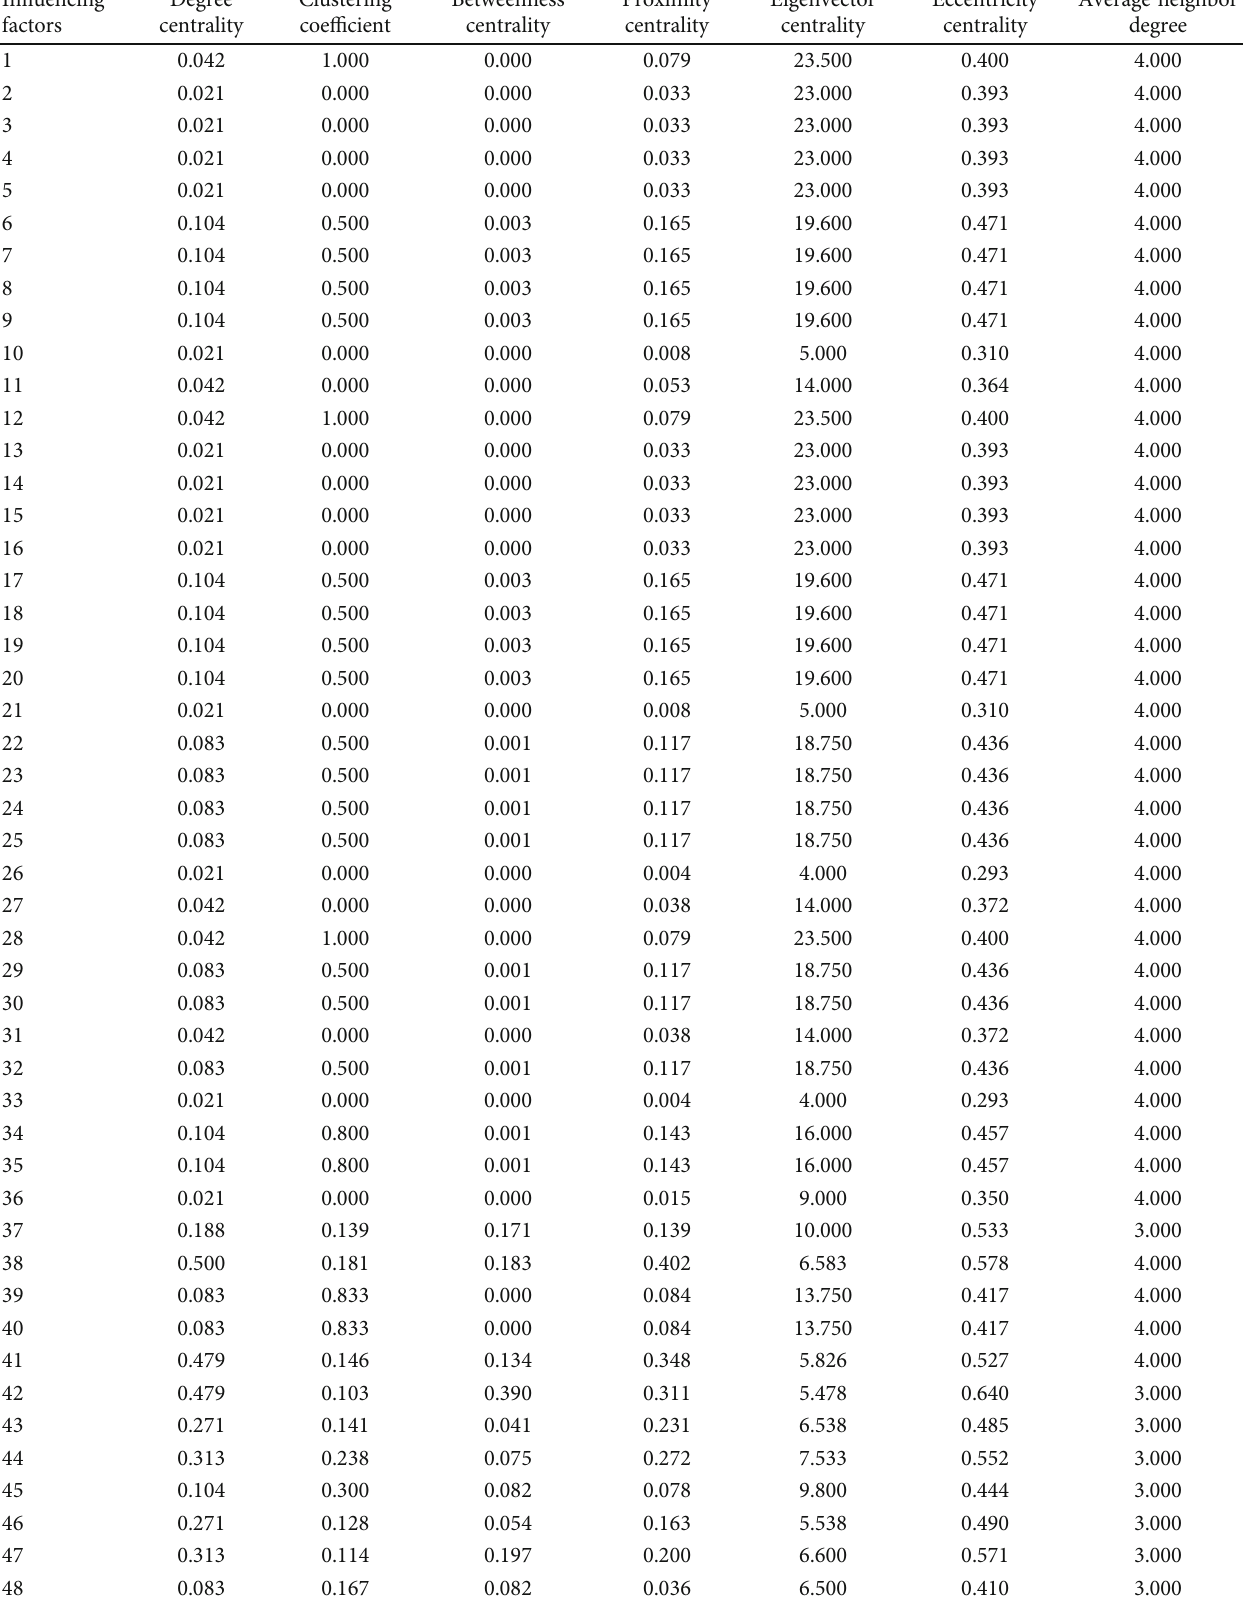
Table 13: The index value of the factors a ff ecting the assembly process of the